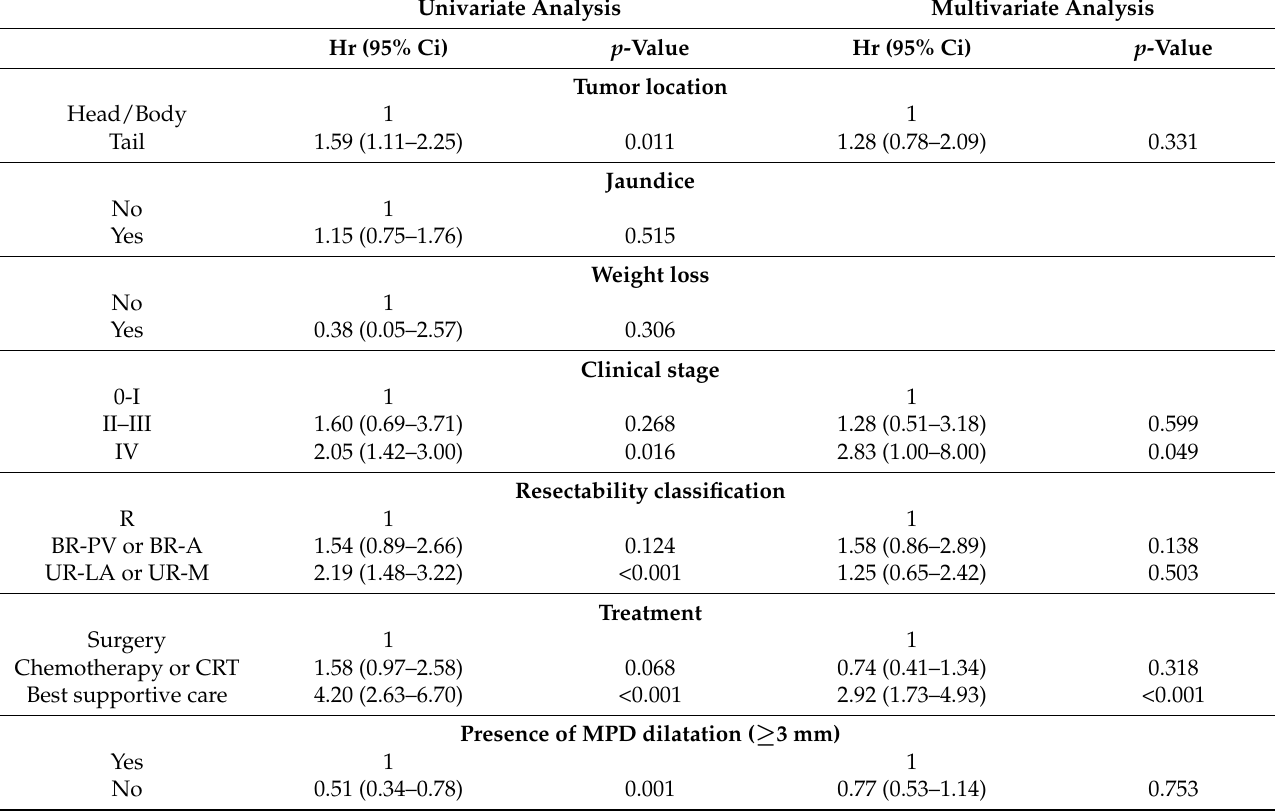
Table 6. Univariate and multivariate analyses of the factors associated with OS. Univariate Analysis Multivariate